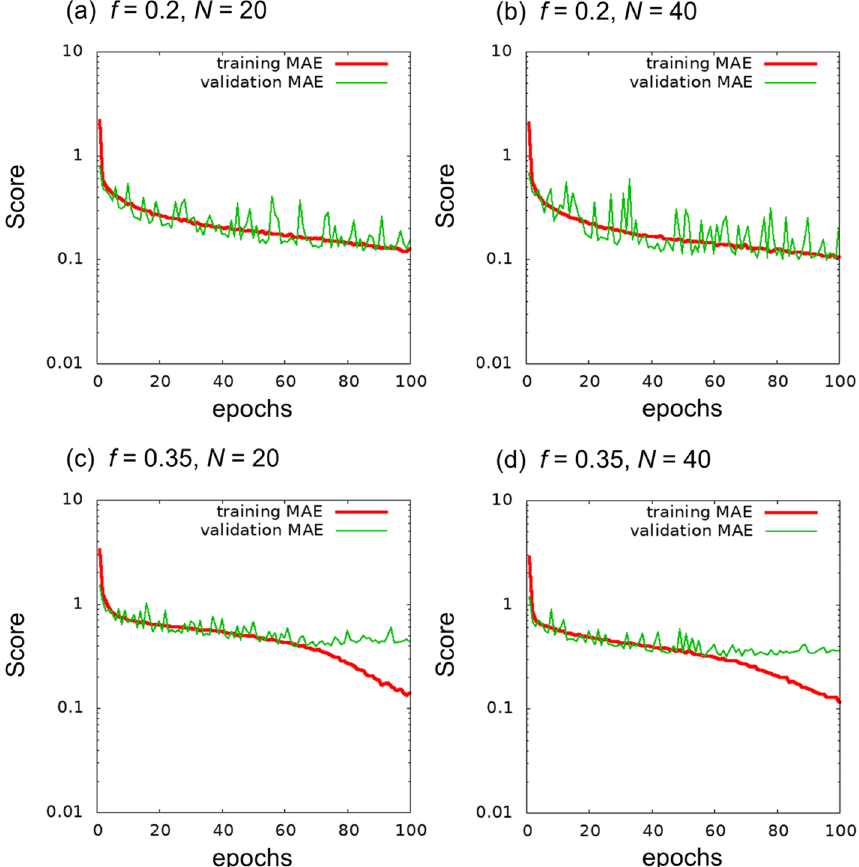
Figure 3. Learning curves of the regression problem until 100